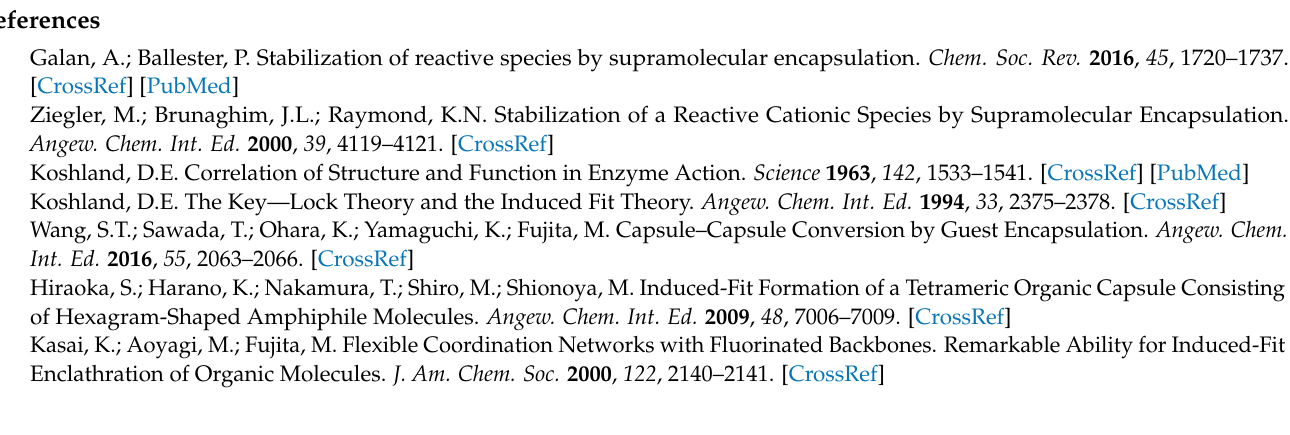
shift changes of H during titration experiments of 2 with perylene. The figure on the left represents the speciation profiles; Figure S15: Selected region and spectra of the titration of complex 2 with 3-perylenyl-methanol; Figure S16: Non-linear least-squares fitting of the chemical shift changes of H during titration experiments of 2 with 3-perylenyl-methanol. The figure on the left represents the speciation profiles; Figure S17: Selected region and spectra of the titration of complex 2 with coronene; Figure S18: Non-linear least-squares fitting of the chemical shift changes of H during titration experiments of 2 with coronene. The figure on the left represents the speciation profiles; Figure S19: Selected region and spectra of the titration of complex 2 with NTCDI; Figure S20: Non- linear least-squares fitting of the chemical shift changes of H during titration experiments of 2 with NTCDI. The figure on the left represents the speciation profiles; Figure S21: Selected region and spectra of the titration of complex 2 with [Pt(CˆNˆC)(CO)]; Figure S22: Non-linear least-squares fitting of the chemical shift changes of H during titration experiments of 2 with [Pt(CˆNˆC)(CO)]. The figure on the left represents the speciation profiles; Figure S23: Selected region and spectra of the titration of complex 2 with [Au(CˆNˆC)(C ≡ CC 6 H 4 -OCH 3 - p )]; Figure S24: Non-linear least-squares fitting of the chemical shift changes of H during titration experiments of 2 with [Au(CˆNˆC)(C ≡ CC 6 H 4 -OCH 3 - p )]. The figure on the left represents the speciation profiles; Figure S25: Selected region and spectra of the titration of complex 2 with TNFLU; Figure S26: Non-linear least-squares fitting of the chemical shift changes of H during titration experiments of 2 with TNFLU. The figure on the left represents the speciation profiles; Figure S27: Selected region of the HRMS ESI-TOF-MS (positive mode) spectrum of 2 ; Figure S28: Selected region of the HRMS ESI-TOF-MS (positive mode) spectrum of 3@2 ; Figure S29: DOSY NMR spectrum of 2 ; S30: DOSY NMR spectrum of 3@2 ; Figure S31: IR spectrum of 2 ; Figure S32: IR spectrum of 3@2 ; Table S1: Data values from the titration study of 2 with pyrene; Table S2: Data values from the titration study of 2 with 1-pyrenyl-methanol; Table S3: Data values from the titration study of 2 with triphenylene; Table S4: Data values from the titration study of 2 with perylene; Table S5: Data values from the titration study of 2 with 3-perylenyl-methanol; Table S6: Data values from the titration study of 2 with coronene; Table S7: Data values from the titration study of 2 with NTCDI; Table S8: Data values from the titration study of 2 with Pt(CˆNˆC)(CO); Table S9: Data values from the titration study of 2 with [Au(CˆNˆC)(C ≡ CC 6 H 4 -OCH 3 - p )]; Table S10: Data values from the titration study of 2 with